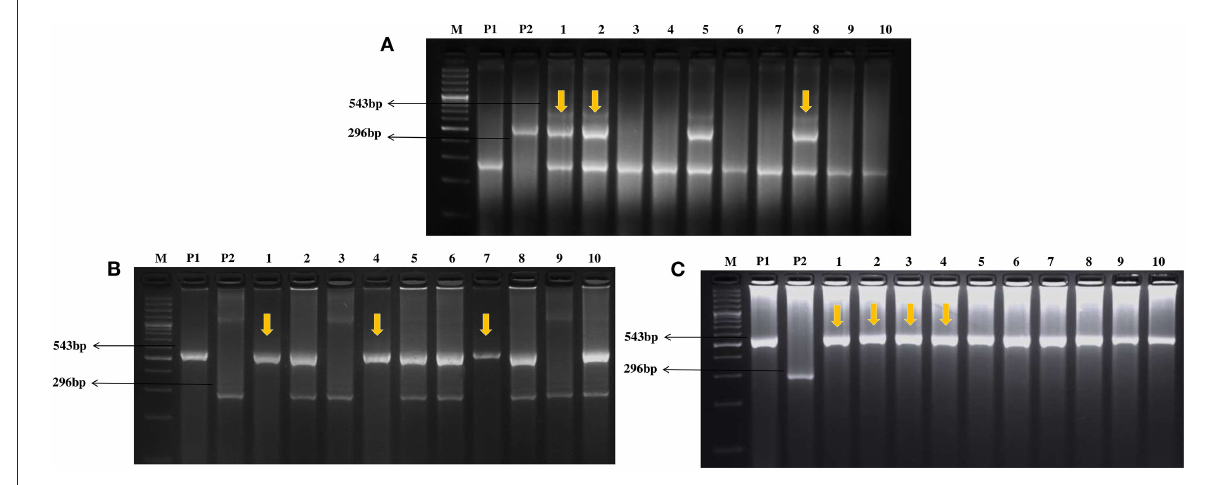
TABLE 1 Segregating pattern of crtRB1 alleles in the backcross and selfed populations derived from SC11-2 × UMI 1230 β 1 + . Cross Generation N Allele 1 Allele 2 Allele 3 df χ 2 P -value SC11-2 × UMI 1230 β 1 + BC 1 F 1 96 35 61 0 1 7.04 0.0080 BC 2 F 1 110 53 57 0 1 0.15 0.7029 BC 2 F 2 152 32 78 42 2 1.42